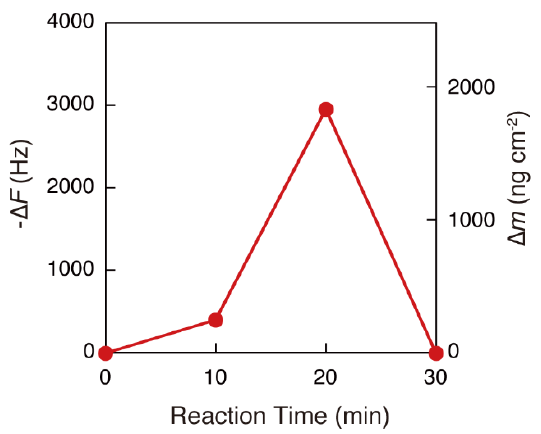
Figure 3. Dependence of the amount of β‐ CD film immobilized on the QCM sensor surface on the reaction time. Table 1. Amount of odorant molecules captured on each cyclodextrin (CD) film.